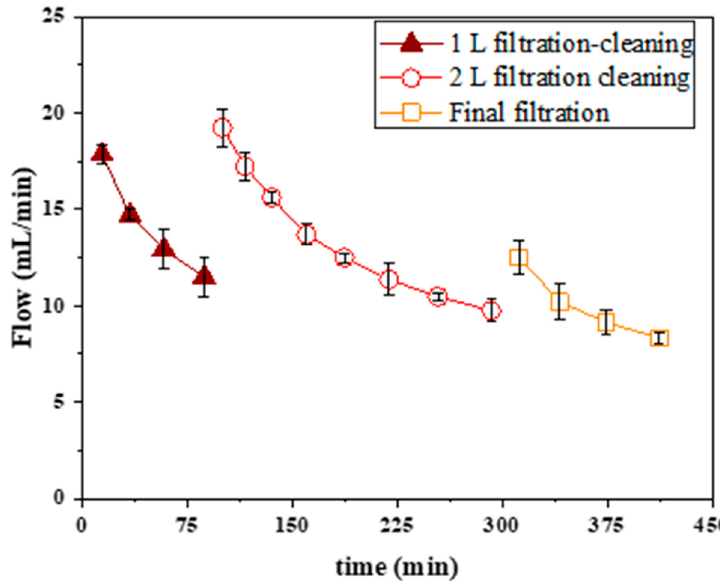
Figure 6. Filtration in the dark with self-cleaning under illumination series of UWWTP effluent spiked with 100 g/L of each MC. Note: (cid:78) , filtration of 1 L, followed by cleaning (60 min); spiked with 100 g/L of each MC. Note:  , filtration of 1 L, followed by cleaning (60 min);  , after cleaning, filtration of 2 L, followed by cleaning (60 min); ‘ (cid:50) ’ after cleaning, filtration cleaning, filtration of 2 L, followed by cleaning (60 min); ‘  ’ after cleaning, filtration again.